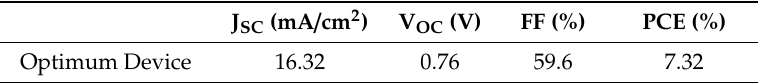
Table 4. Photovoltaic parameters of a state-of-the-art bulk heterojunction organic solar cell fabricated PTB7:PC71BM as the active layer blend.